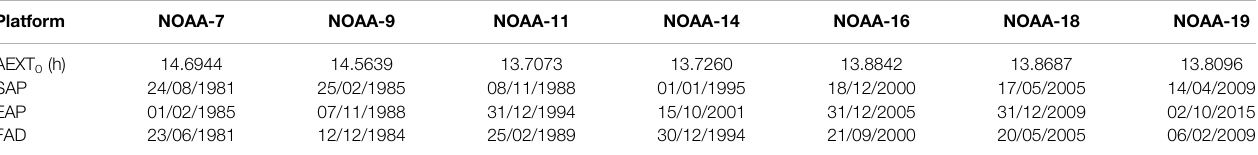
TABLE 2 | Characteristics of NOAA platforms. AEXT 0 : average of the equatorial crossing times over the fi rst year of each platform; SAP: start of activity period; EAP: end of activity period; FAD: fi rst available data. Platform